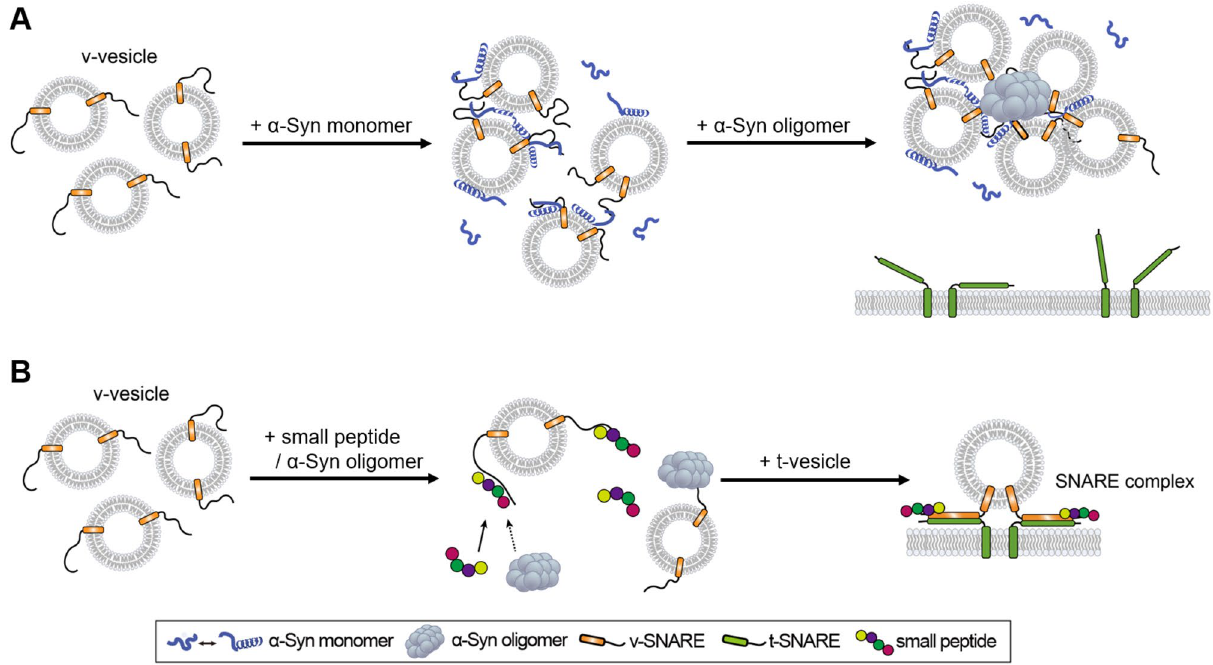
Figure 6. Proposed models for the cooperative inhibition of vesicle fusion by α-Syn monomer and oligomers and the reversal of α-Syn oligomer fusion inhibition. ( A ) The α-Syn monomer binds to lipid membranes and Syb2, which may induce a low degree of vesicle clustering 29,30,38,41 . α-Syn oligomers, which bind to Syb2, generate large clusters of v-vesicles with the help of the α-Syn monomer, which inhibits vesicle fusion. ( B ) Small peptide fragments derived from the C-terminal domain of α-Syn compete with α-Syn oligomers in binding Syb2. As a result, α-Syn oligomers cannot bind to Syb2 and induce the clustering of v-vesicles, which restores the formation of the SNARE complex and vesicle fusion. These figures were generated by Adobe Illustrator CS6 (Supplementary Figs. S9, S10, and S11). CFα1 and CFα2 effectively reversed the fusion inhibitory effect of α-Syn oligomers: 200 nM CFα1 increased the fusion efficiency from 45 to 68% (blue bars in Fig. 5B; Supplementary Fig. S9), and 200 nM CFα2 increased the fusion efficiency from 45 to 90% (orange bars in Fig. 5B; Supplemen- tary Fig. S10). However, CFα3 had no effect on vesicle fusion in the presence of α-Syn oligomers (green bars in Fig. 5B; Supplementary Fig. S11). These results imply that the small peptide-induced reversal of fusion inhibi- tion is sequence dependent, and thus, a specific interaction between small peptides and Syb2 is required for the reversal. The 96–125 C-terminal region of α-Syn seems to be used mostly for binding to Syb2, consistent with previous work suggesting that α-Syn 96–110 is the key domain for Syb2 binding 38 . For control experiments, no change in lipid mixing was observed with 250 nM peptides in the absence of α-Syn oligomers, while 500 nM peptides slightly reduced lipid mixing (Fig. 5C). In order to be used as clinical drugs, it needs to be tested whether the small peptides have any effect on the functions of α-Syn monomer by interfering the interactions between α-Syn monomer and Syb2 in animal models. At least, however, we showed that the small peptides do not interfere the SNARE-mediated vesicle fusion (Fig. 5C). In the presence of 500 nM α-Syn monomers, no change in the SNARE-mediated vesicle fusion was observed for in vitro FRET assays (Supplementary Fig. S12). Then, we tested whether the small peptides bind to the lipid membrane. When we added 20 μM protein- free liposomes (F) to a 20 μM T-V mixture, no change in the reversal effect of CFα1 and CFα2 was observed (Fig. 5D). Dopamine-induced α-Syn oligomers do not bind to lipid membranes 15 . Thus, this result indicates that the CFα peptides, as expected, do not bind to lipid membranes (Fig. 5D). All these results indicate that the small peptides of CFα1 and CFα2 reverse the fusion inhibitory effect of α-Syn oligomers by disrupting the specific